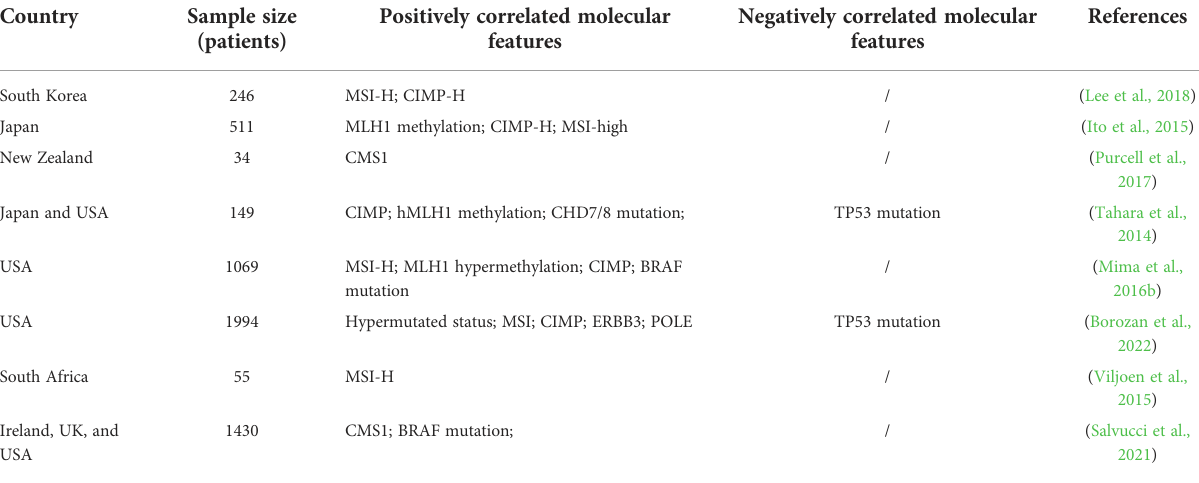
TABLE 1 Molecular characteristics of CRC related to